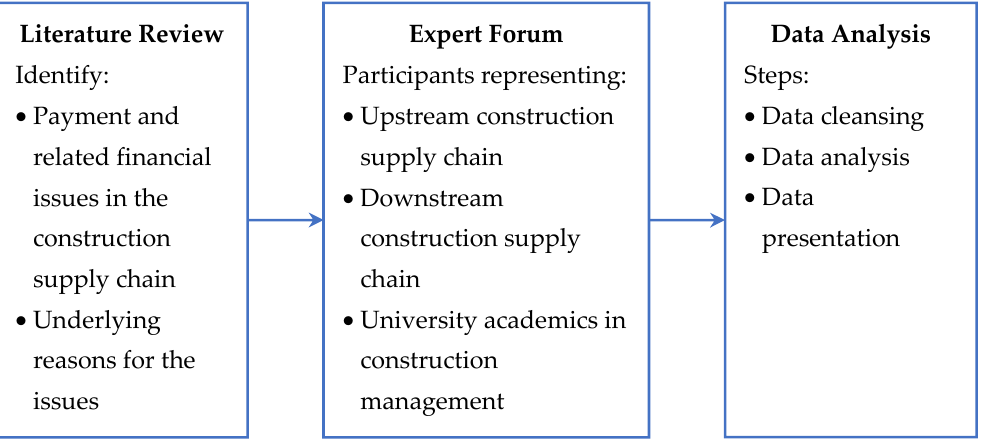
Figure 3. Research methodology.